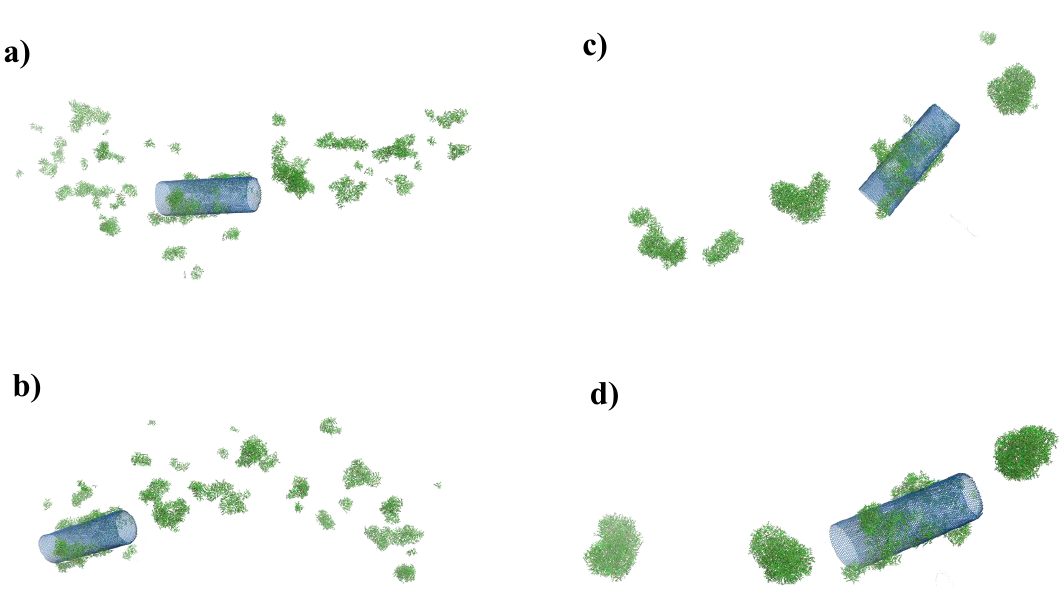
Figure 7. MD snapshots of a DOX (green) with a SWCNTs (blue), mass ratio 4(DOX):1(SWCNTs): ( a ) t = 0.5 ns; ( b ) t = 1 ns; ( c ) t = 5 ns; ( d ) t = 20 ns.